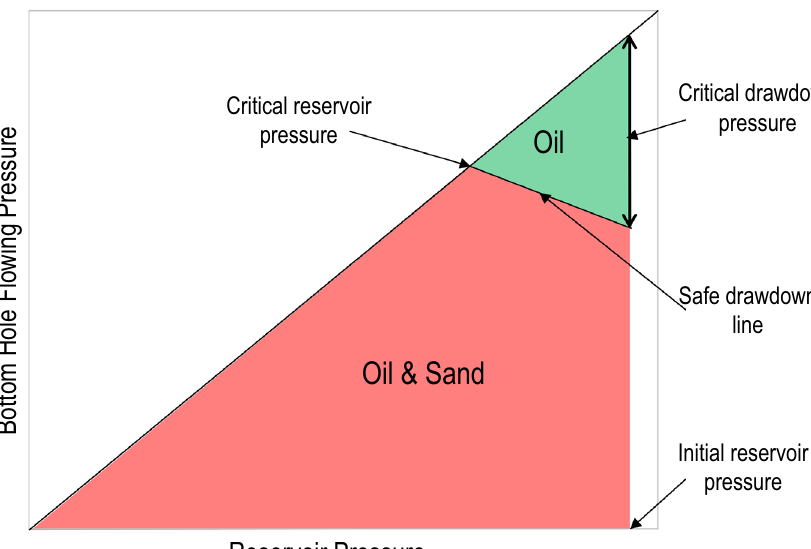
Fig. 26 Safe drawdown window plot at a single depth